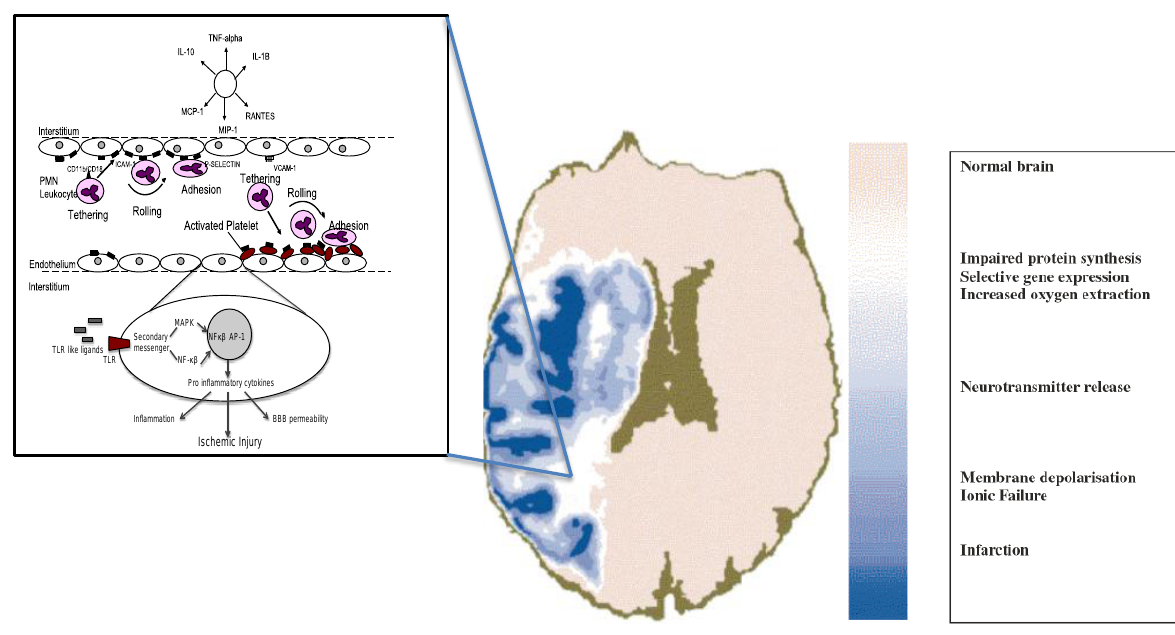
Figure 2. Two conceptual frameworks of Ischemic Stroke: the Penumbra and the Neurovascular Unit. The heterogeneity of the ischemic penumbra is illustrated. From the onset of focal ischemia the core and the penumbra are dynamic in space and time. A region of low perfusion in which cells have lost their membrane potential (core) is surrounded by an area in which intermediate perfusion prevails (penumbra) and cells depolarize intermittently. The CBF and metabolic viability thresholds (scale on right of figure) identify reversible and irreversibly injured tissue. The potentially reversible injury is modified by microvascular cellular and molecular responses at the level of the neurovascular unit (NVU, inset figure on left), mechanisms that include vasogenic oedema, BBB dysfunction and hemorrhagic transformation. During ischemia endothelial cells express PAR1, tissue factor (TF) and matrix metalloproteinases (MMPs). Together these facilitate the endothelial inflammatory response causing aggregation of platelets, fibrin degradation and leukocyte recruitment. These phenomenon potentially contribute to microvascular “no reflow”. Also leukocytes adherent to endothelium can cause endothelial dysfunction, transvascular protein leakage and oedema, leading to brain injury. MMPs contribute to the degradation of extracellular matrix causing an increase in BBB permeability. Endogenous ligands from damaged cells cause the expression of Toll Like Receptors (TLRs). Through complex signaling pathways pro-inflammatory cytokines are produced via transcription factors such as NFκβ and